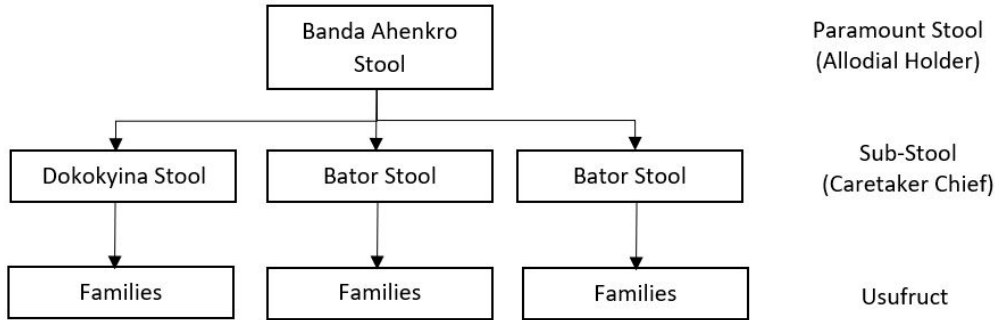
Figure 2. Chieftaincy and land tenure hierarchy in the area (author’s construct).